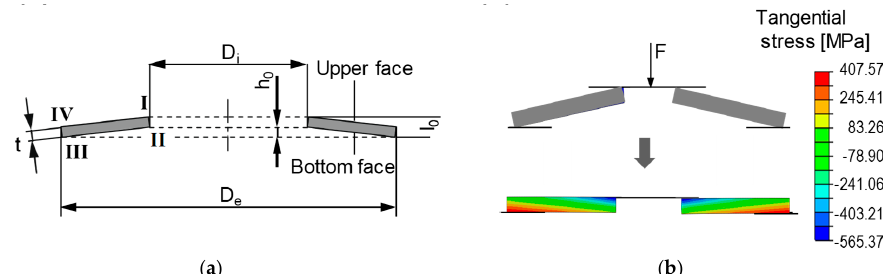
Figure 1. ( a ) The schematic of a conventional disc spring geometry. ( b ) Development of the stresses in disc springs under normal loading condition. disc springs under normal loading condition.